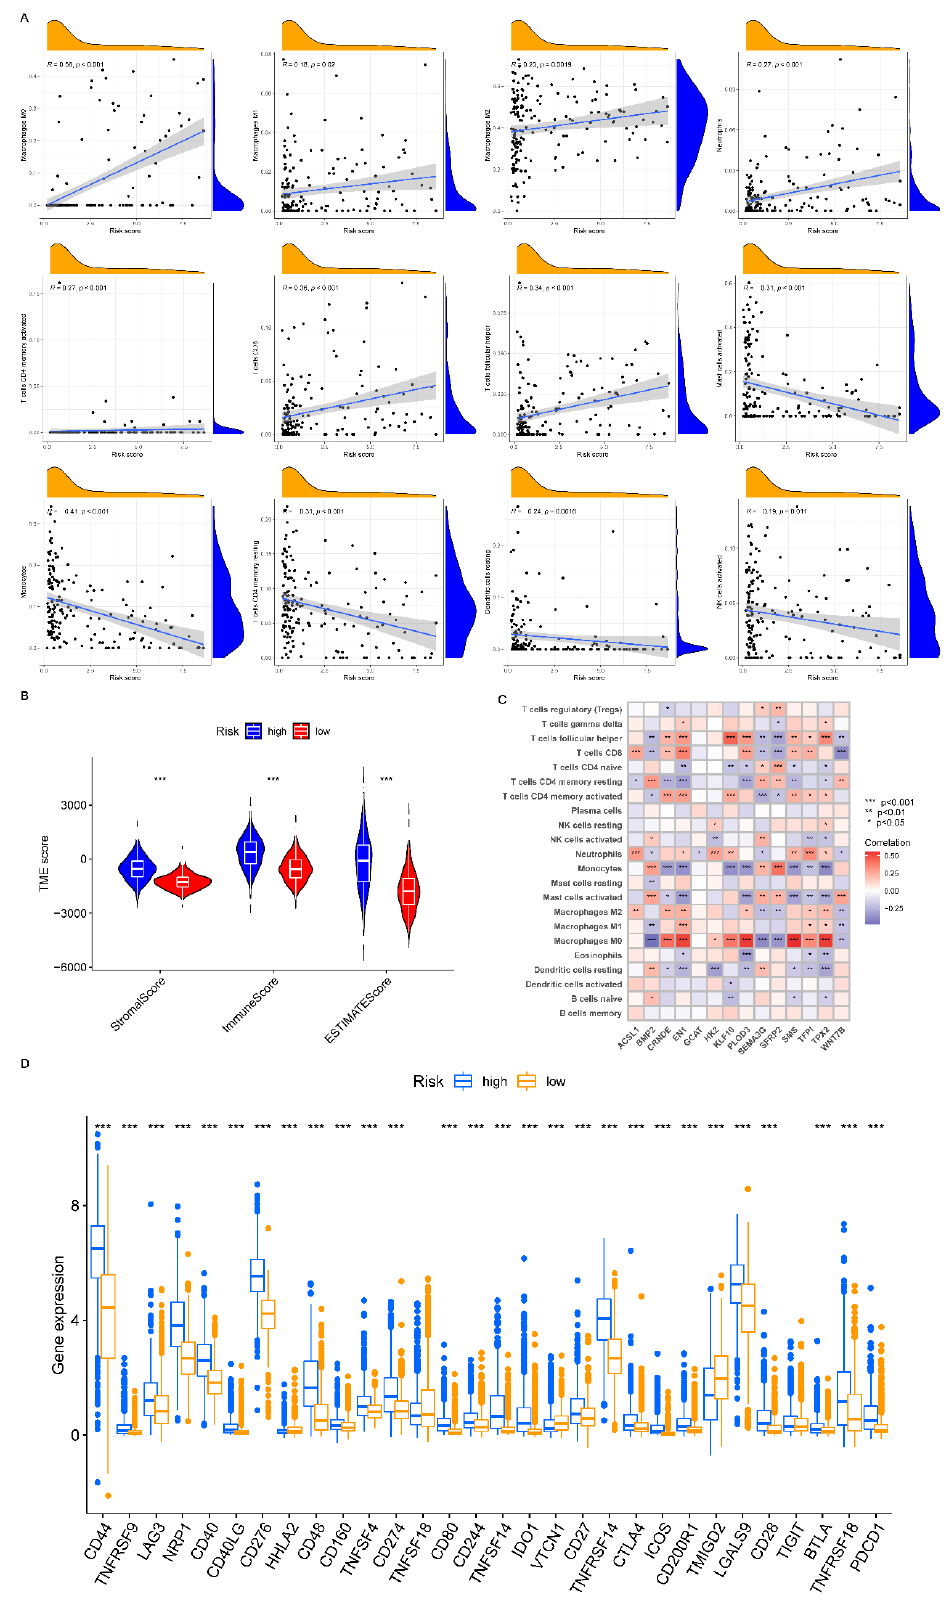
Figure 6. Analysis of TME and checkpoint genes between the different risk groups. ( A ) Relationships between risk scores and 12 immune cells. ( B ) Relationships between risk groups and TME